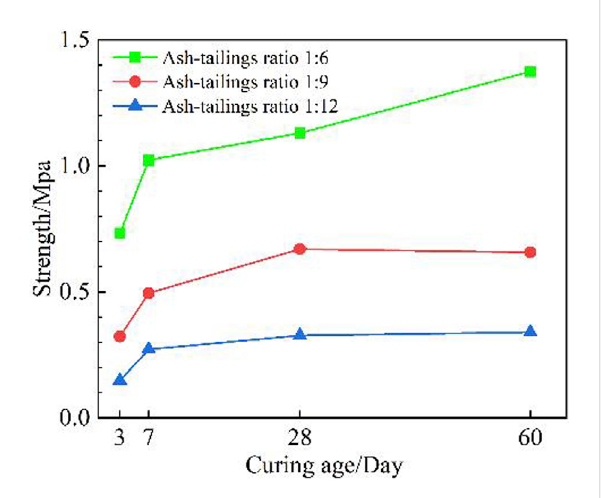
FIGURE 8 Variation of the strength of back fi ll materials for 52% concentration with the ash-tailings